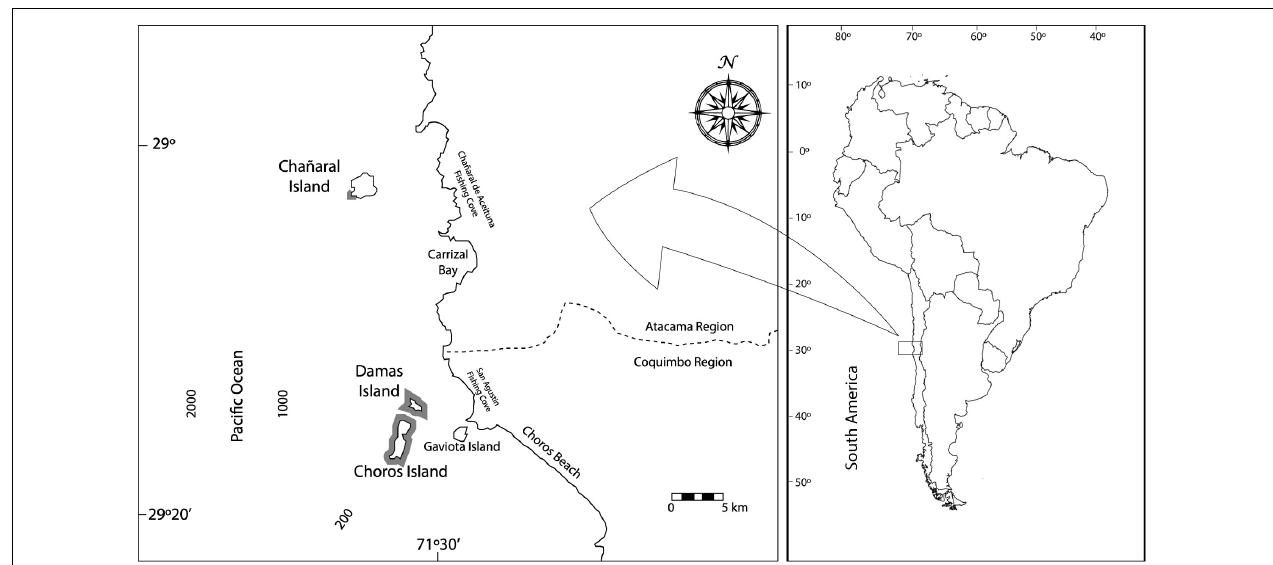
FIGURE 1 | Map of the study area in coastal waters of the Humboldt Current, northern Chile. The gray shaded area at Southwest of Chañaral Island shows the study area for the T1 period without whale watching (1989–1992) and around Chañaral and Damas, Gaviotas, and Choros Islands for T2 with whale watching (2010–2020). In both areas, at least 50% of dolphins were the same individuals. TABLE 1 | Details of definitions of surface behavior and the response to boat disturbance for bottlenose dolphins ( Tursiops truncatus ) (Bearzi et al., 1999 and Bearzi et al., 2005 modified).